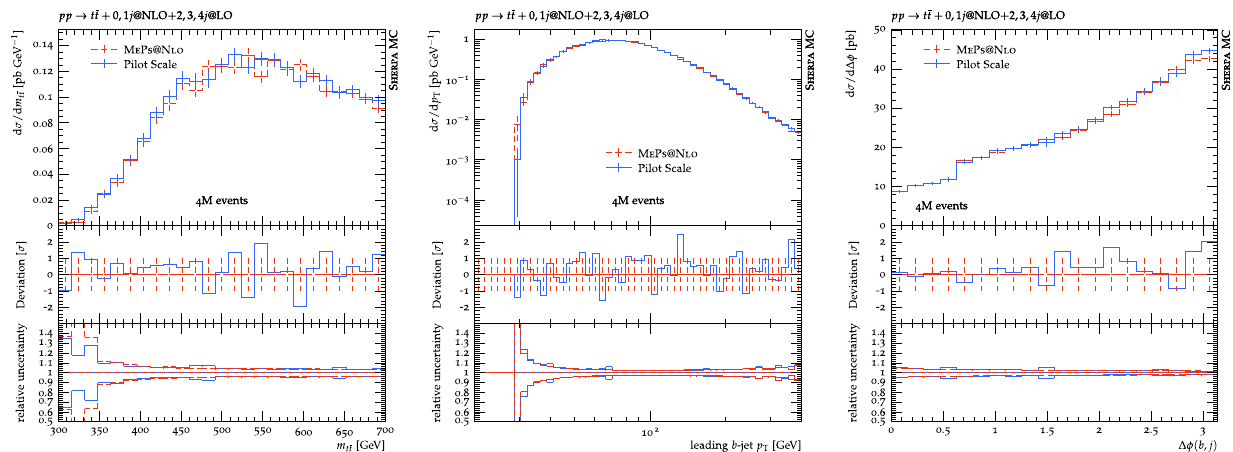
Fig. 7 Predictions for the Born-level observable m t ¯ t , for the leading b -jet transverse momentum and the azimuthal difference between the leading b -jet and the leading light-flavour jet in comparison between the M E P S @N LO algorithm (red dashed) or the pilot scale strategy (blue solid) described in Sect.